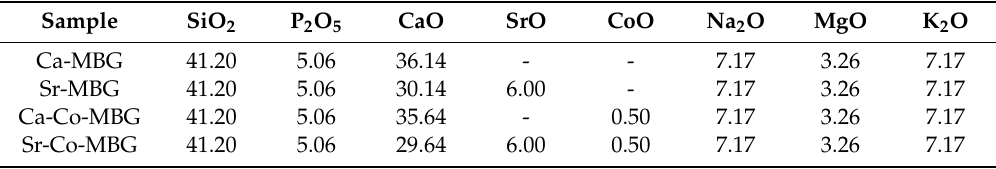
Table 1. Nominal compositions (mol.%) of the MBGs produced in this work. The calculations were carried out by using Outotec HSC Chemistry Software